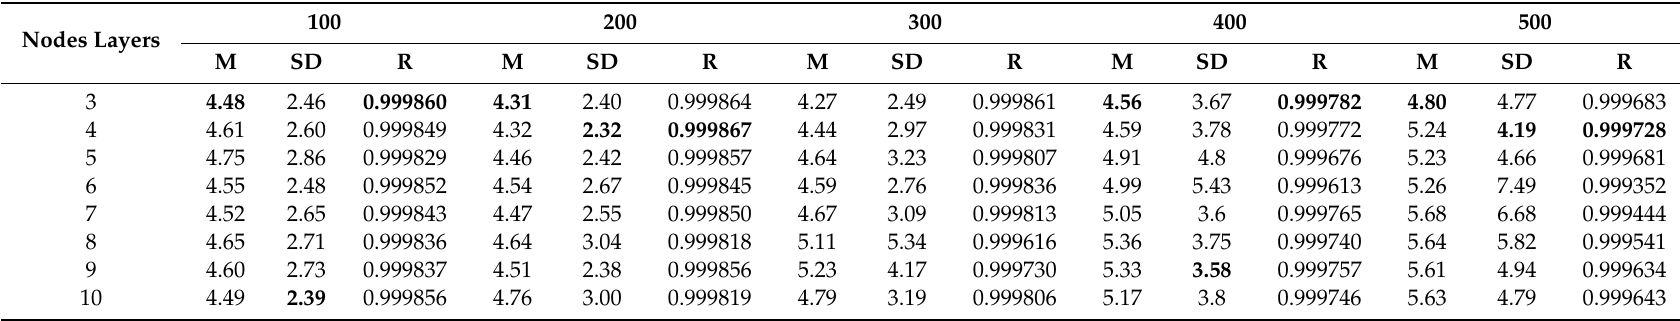
Table 3. Summary of the retrieval errors for obtaining the CMI. (M: mean error, R: correlation coe ffi cient, and SD: standard deviation of the fit). The actual value of M and SD are the value in the table times 10 − 3 . For all columns, the minimum M with maximum R and minimum SD is indicated in bold. Nodes